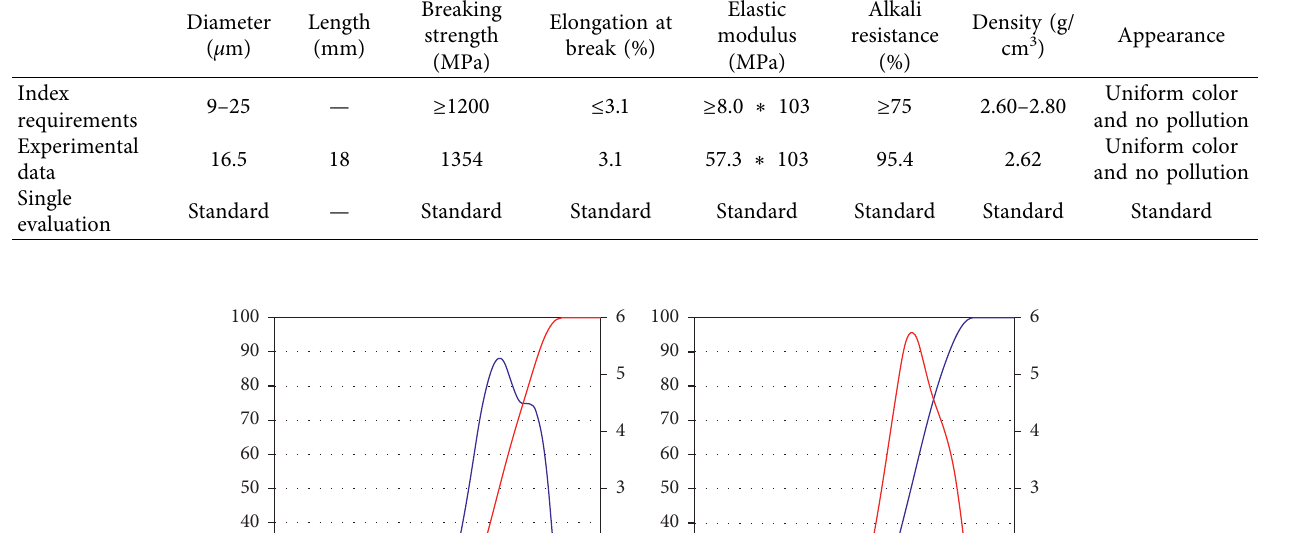
Table 5: Basalt fiber